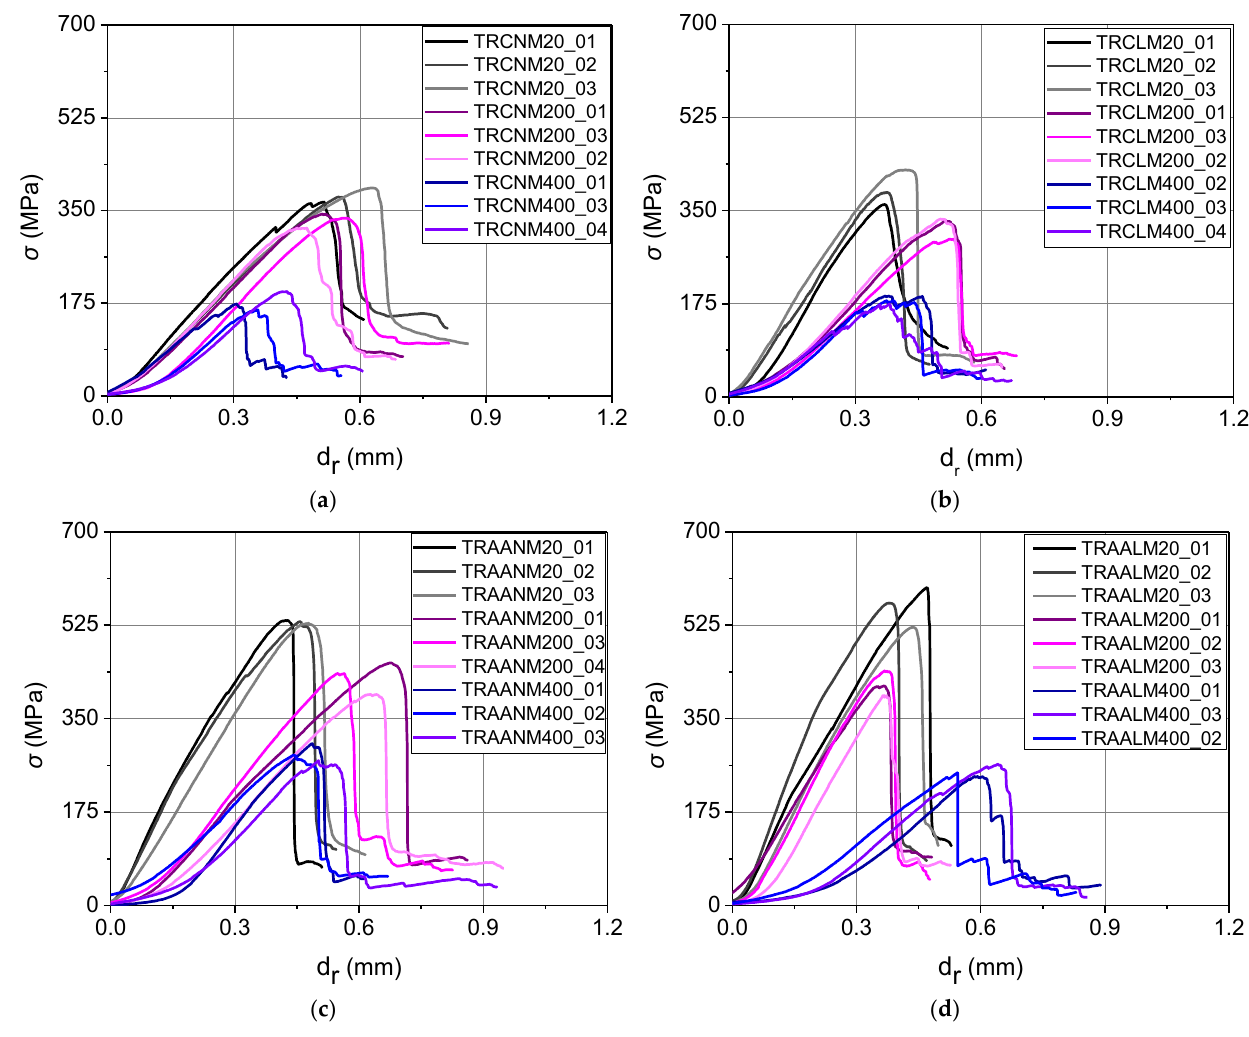
Figure 9. The response curves – textile axial stress ( σ ) versus the textile relative displacement with respect to the substrate ( d r ) – of the SL/SP specimens that were reinforced with TRM overlays comprising cementitious ( a ) normal-weight or ( b ) lightweight matrix and alkali-activated ( c ) normal- weight or ( d ) lightweight matrix.